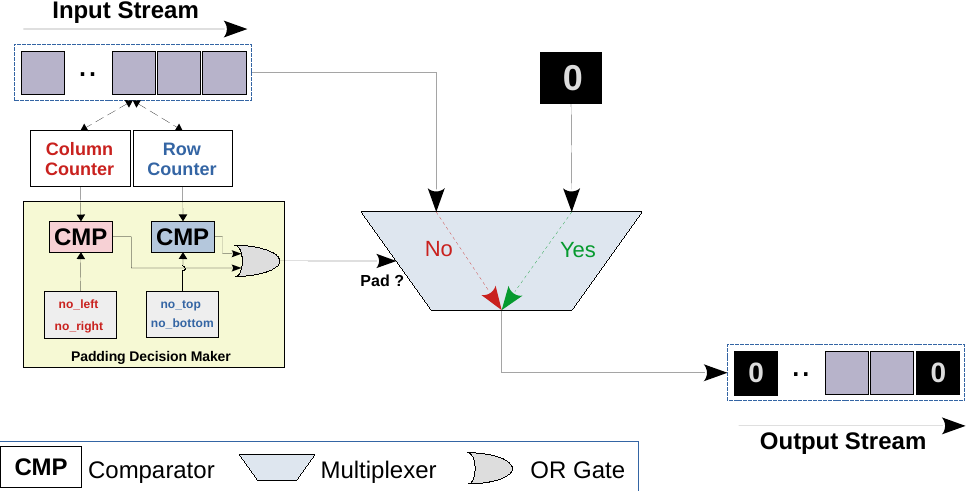
Figure 5. Zero padding layer streaming architecture. In this architecture, the input values are streamed in, and the padding decision maker controls the multiplexer based on the current row and column indices. If the padding should be performed, a zero value is streamed out and the input stream stalls. Otherwise, the input value is directly pushed as is to the output